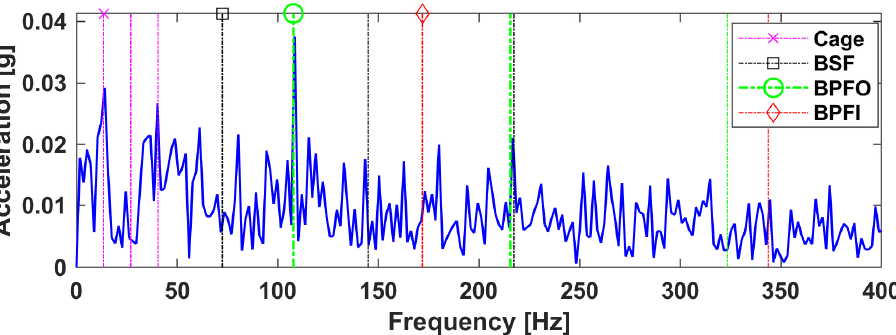
Figure 8. Case A result via LRANTD: The amplitude spectrum of TS 4 with clear outer-race fault